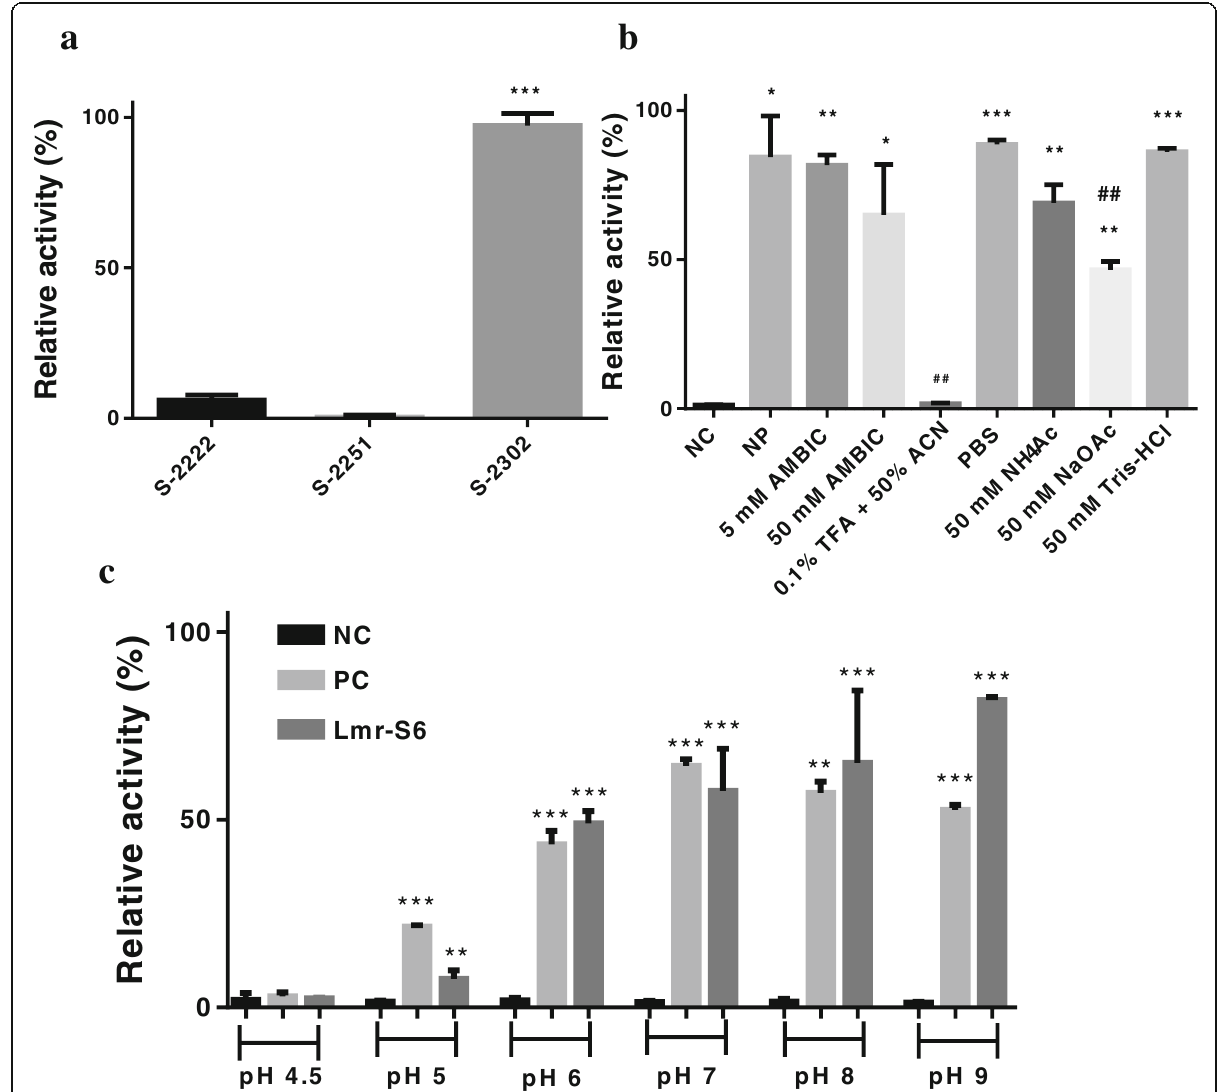
Fig. 4 Proteolytic activity of the fraction LmS-6. a upon 0.4 mM chromogenic substrates (Chromogenix®) for plasma kallikrein (S-2302), plasmin and plasminogen activated by streptokinase (S-2251) and Factor Xa (S-2222). *** p < 0.0001 compared among the tested substrates. b in the presence of different solutions. LmS-6 fraction (5 μ g) was incubated with 5 and 50 mM AMBIC, pH 7.8; 0.1% TFA + 50% ACN; PBS, pH 7.4; 50 mM NaOAc, pH 4; 50 mM NH 4 OAc, pH 4.5 and 50 mM Tris-HCl, pH 8.0 at 37 °C for 90 min. Each point represents the mean ± SD ( n = 3), * p < 0.05, ** p < 0.01 and *** p < 0.0001 compared to the negative control. The ## symbol represent the significant values when compared to PBS. c pH-profile of LmS-6 fraction at different pHs (4.5 – 9.0). Each point represents the mean ± SD ( n = 3), * p < 0.05, ** p < 0.01 and *** p < 0.0001 compared to the controls (one-way ANOVA, followed by Dunnett ’ s test). NC is negative control and PC positive